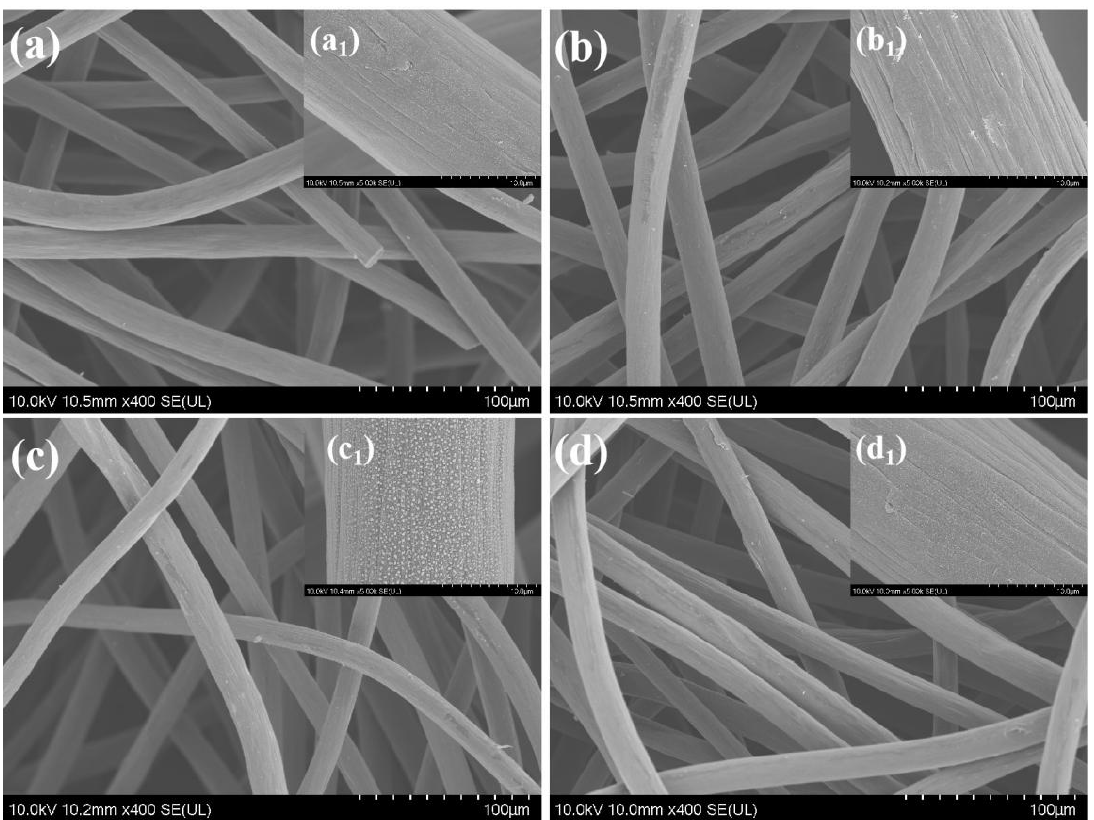
Figure 3. FE-SEM images of Ag x -C-fiber substrates prepared with different sputtering time: ( a ) Ag 15 -C-fiber substrate; ( b ) Ag 20 -C-fiber substrate; ( c ) Ag 25 -C-fiber substrate and ( d ) Ag 30 -C-fiber substrate. ( a 1 – d 1 ) The corresponding amplifying FE-SEM images of ( a – d ).